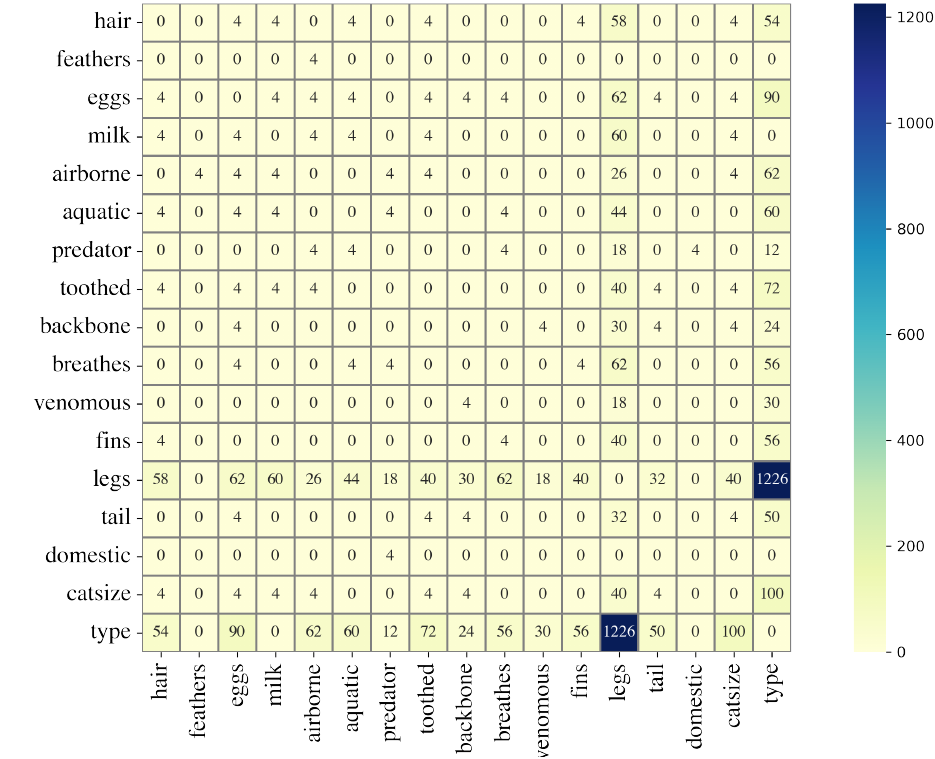
Figure 3. Associations detected in Zoo data